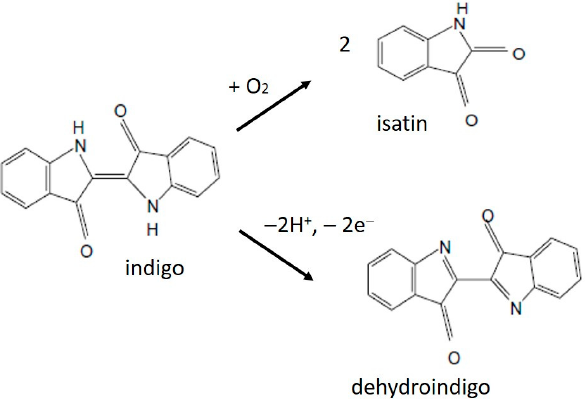
Scheme 1. Oxidation processes of indigo to isatin and